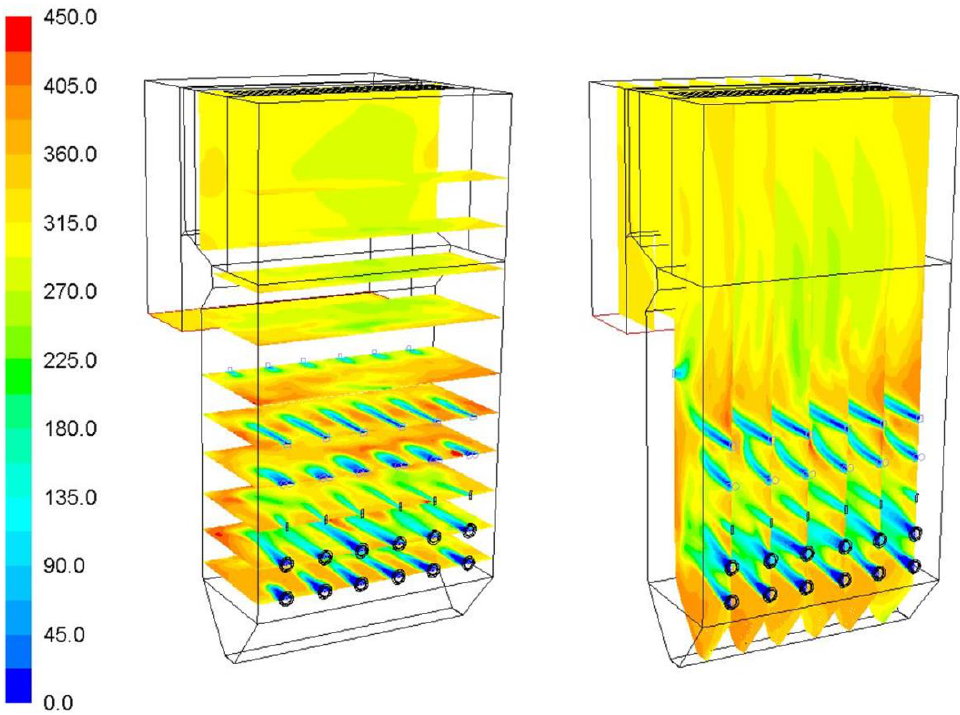
Figure 10. NO x content converted to 6% of O 2 in dry flue gas (mg/m 3n ) in the axis of the burner planes.